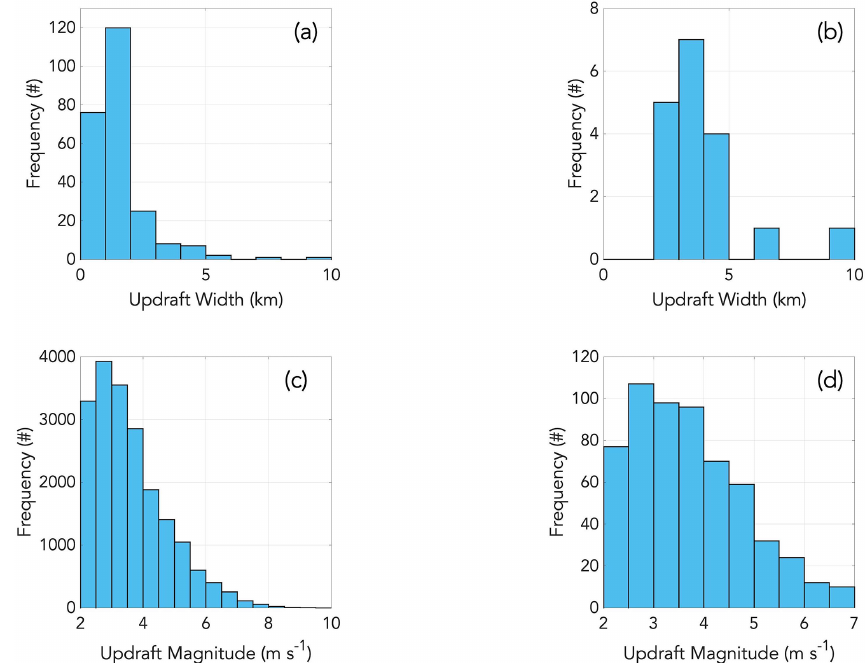
Figure 4. From all 13 COMBLE cases, histograms of updraft chord length (width) in km and range of magnitudes in the updraft in ms − 1 at a horizontal resolution of (a–b) 250m and (b–d) 1km.